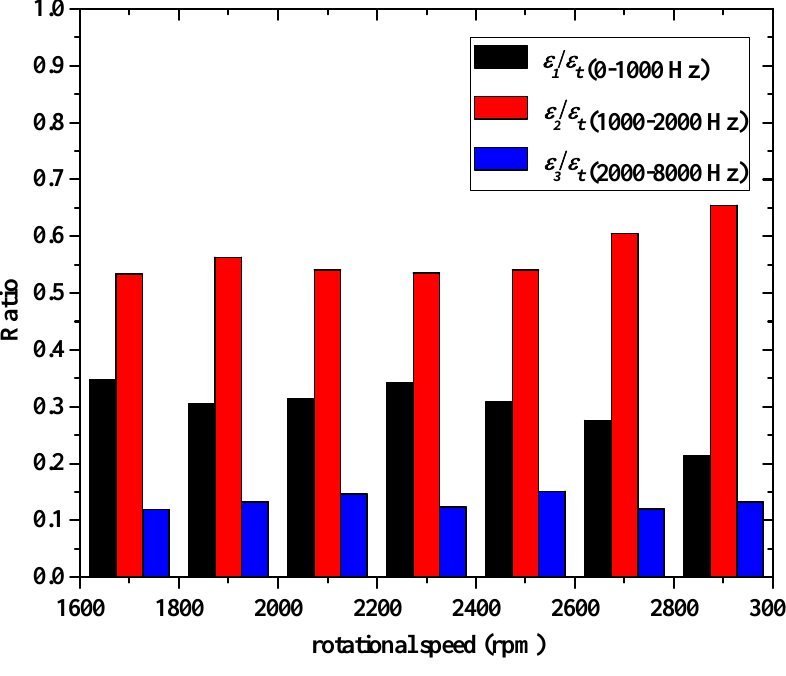
Figure 5. The ratio of acoustic energy in different frequency ranges.